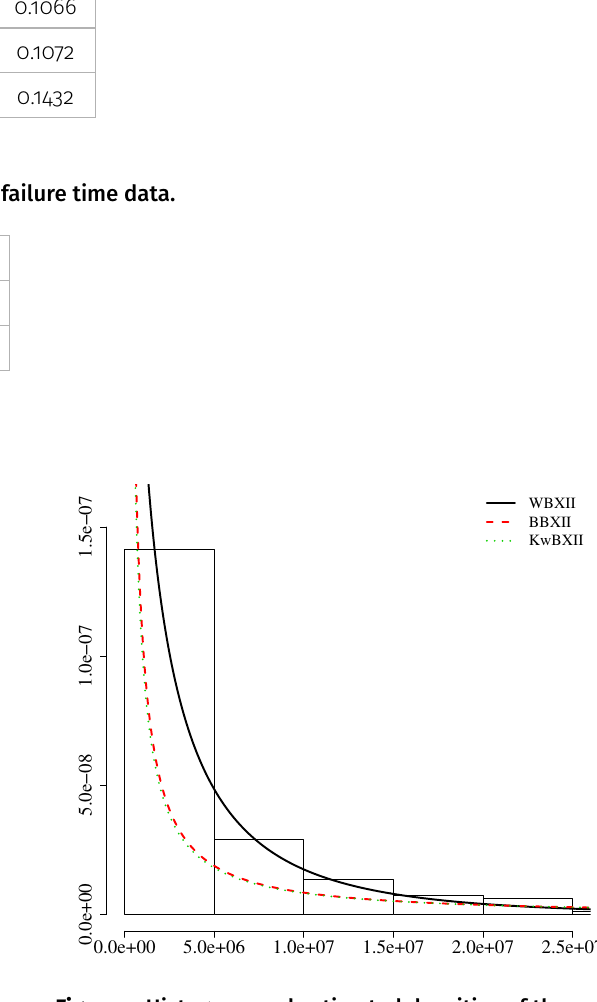
Figure 5. Histogram and estimated densities of the WBXII, BBXII and KwBXII models for the baseball players